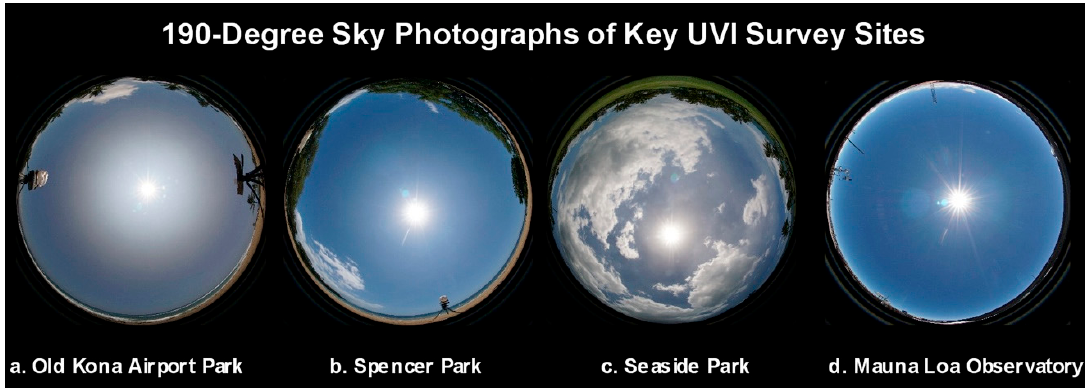
Figure 15. Full sky photographs at the four measurement sites in Figure 14.